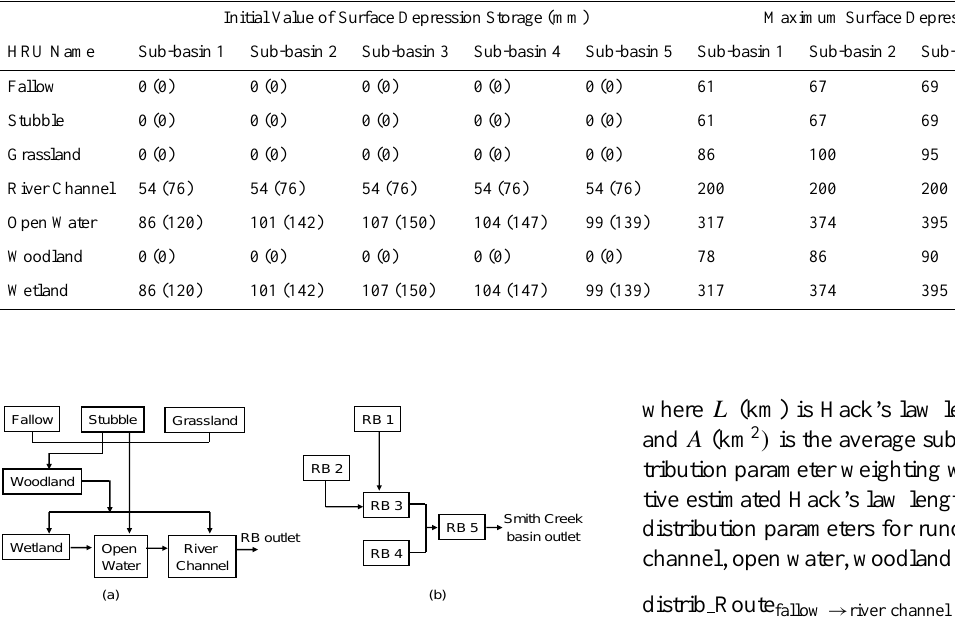
Table 1. Parameters of surface depression storage for the wetland module. The initial values inside parentheses are for the fall of 2008 and the initial values outside parentheses are for the fall of 2007.